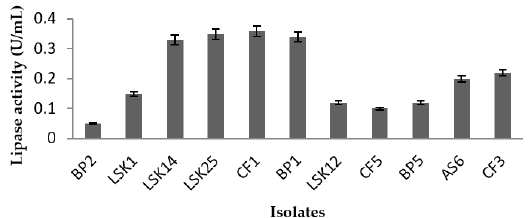
Figure 2 . Lipase activity of 11 isolates that tested positive in qualitative analysis. Lipase activities are represented by mean value ± standard deviation (n = 3).